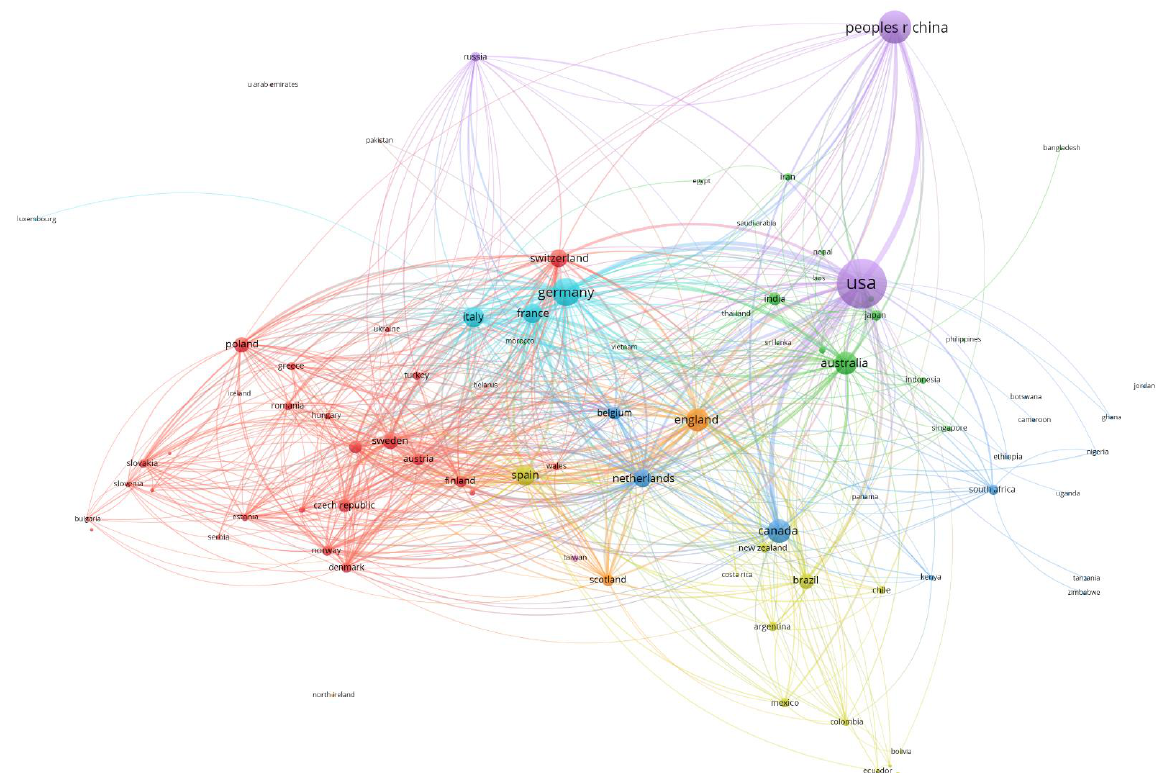
Figure 4. Co-authorship cluster map. Graph obtained by VOSviewer software.